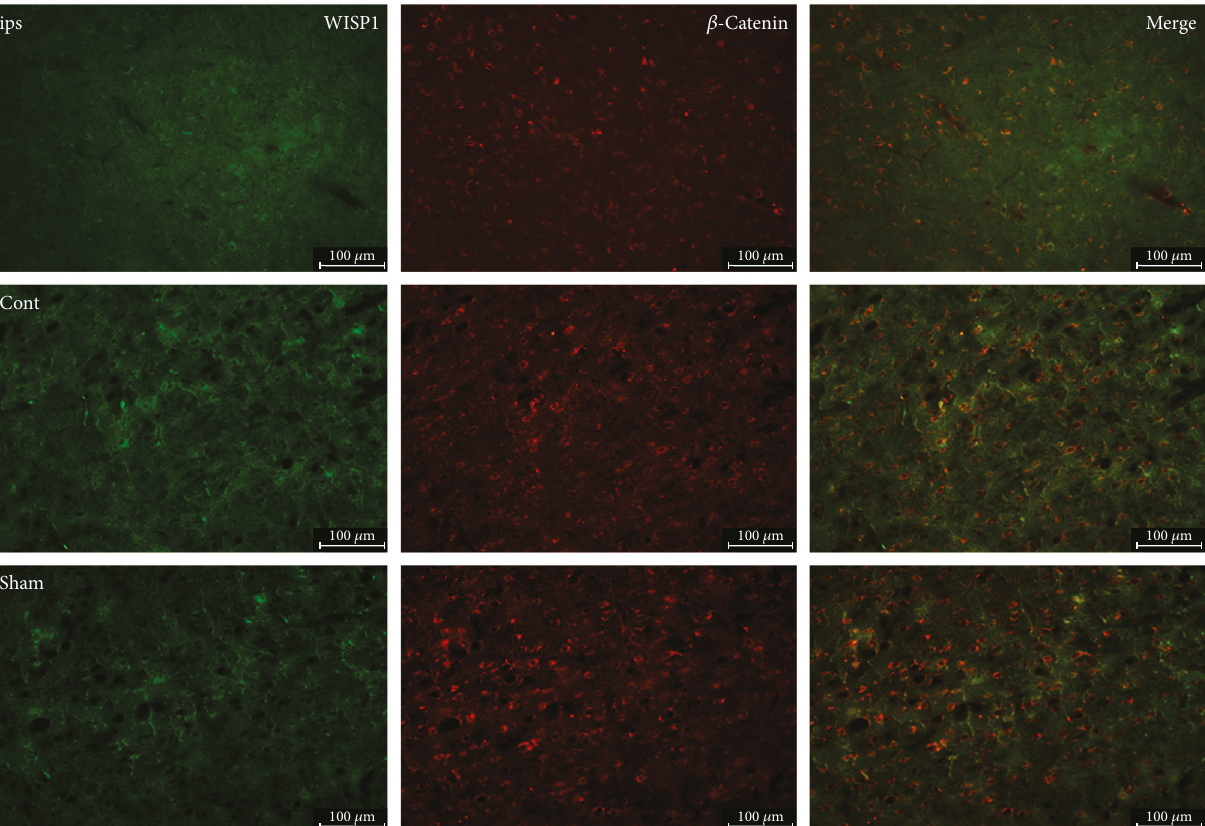
Figure 8: Double-labeling immuno fl uorescence of WISP1 and β -catenin at 3 d after TBI. Green: WISP1; red: β -catenin; cont: the control of ipsilateral 3d post-TBI group; ips: ipsilateral 3d post-TBI group; sham: sham group; bar =100 μ